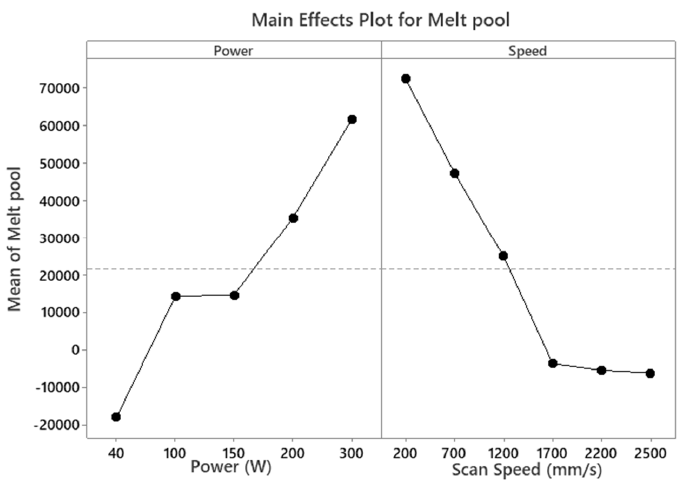
Figure 8. Individual impact of laser power and scan speed on mean contact angle. Table 4. Analysis of variance .